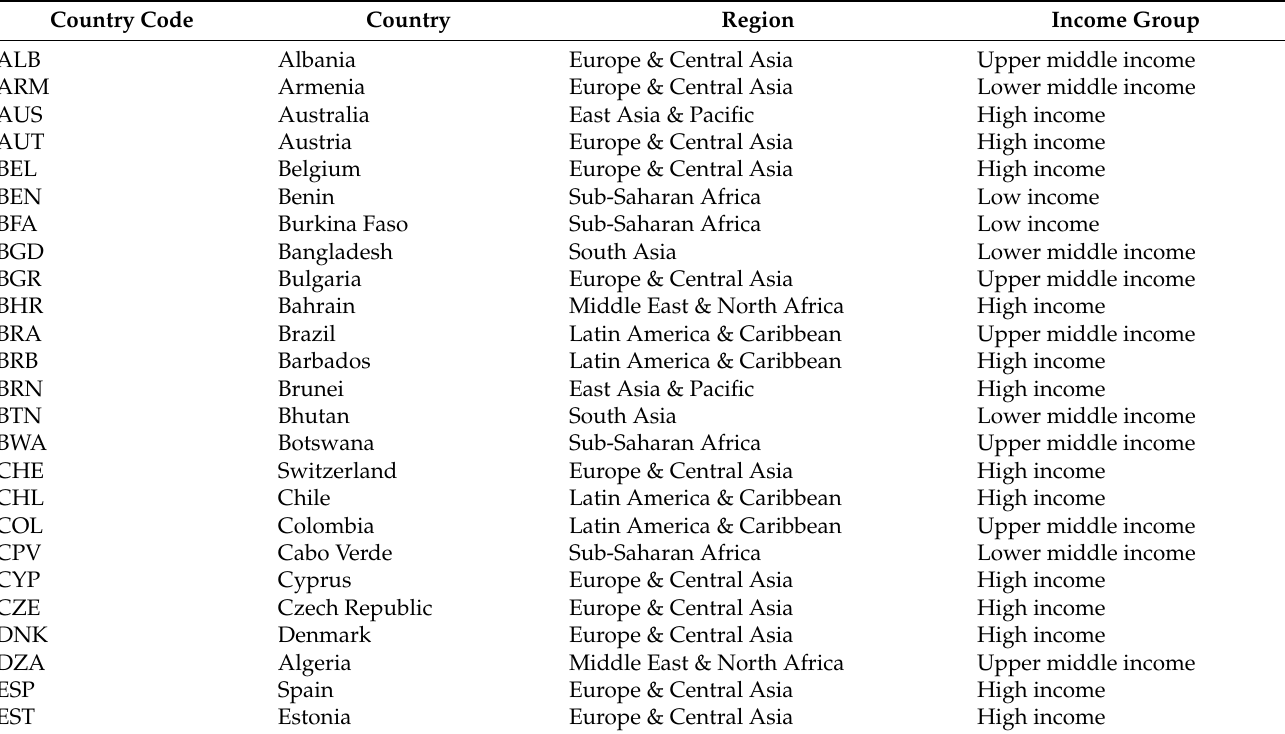
Table A1. List of